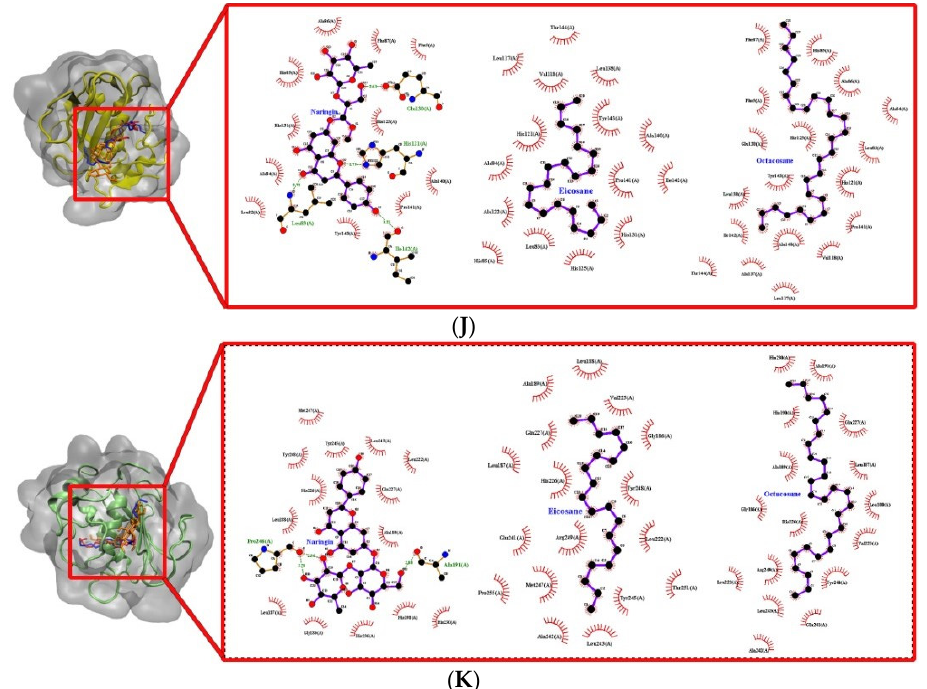
Figure 12. Docked conformation and interaction analysis of ( a ) COL1 ( b ) COL2 and ( c ) COL3 ( d ) STRO1 ( e ) STRO2 (f) STRO3 ( g ) Matrilysin ( h ) Metalloelastase ( i ) Metalloproteinase ( j ) GEL A and ( k ) GEL B against NAR (orange – i), EIC (red – ii) and OCT (blue – iii). The compounds were docked at the binding sites of the control ligand/co-crystallized ligand. Hydrophobic interaction is represented as spokes whereas hydrogen bonding interaction is represented with the green dotted line. Table 4. Lowest binding energies of studied compounds with the proteins. Protein Free Energy of Binding (Kcal/mol) Protein Control